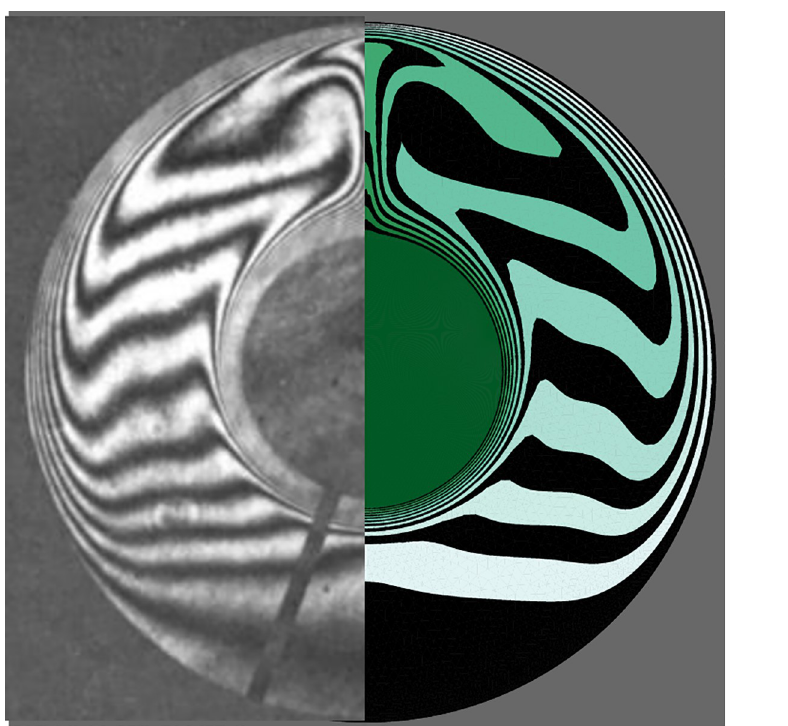
Fig 7. The experimental observations of [53] (right) and the present simulation